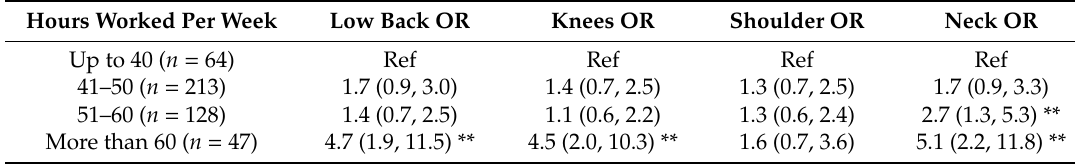
Table 5. Odds ratios of MSS by hours worked per week.